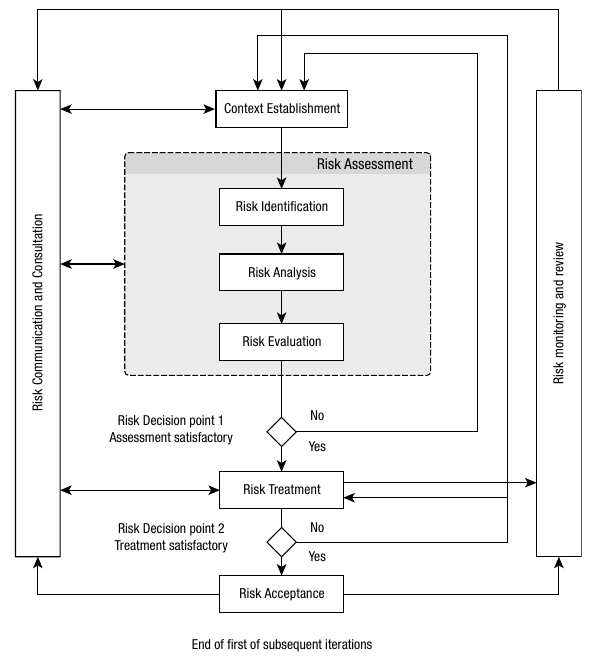
Fig. 2. Risk management standard ISO 27005 (Vandenbrink 2012)